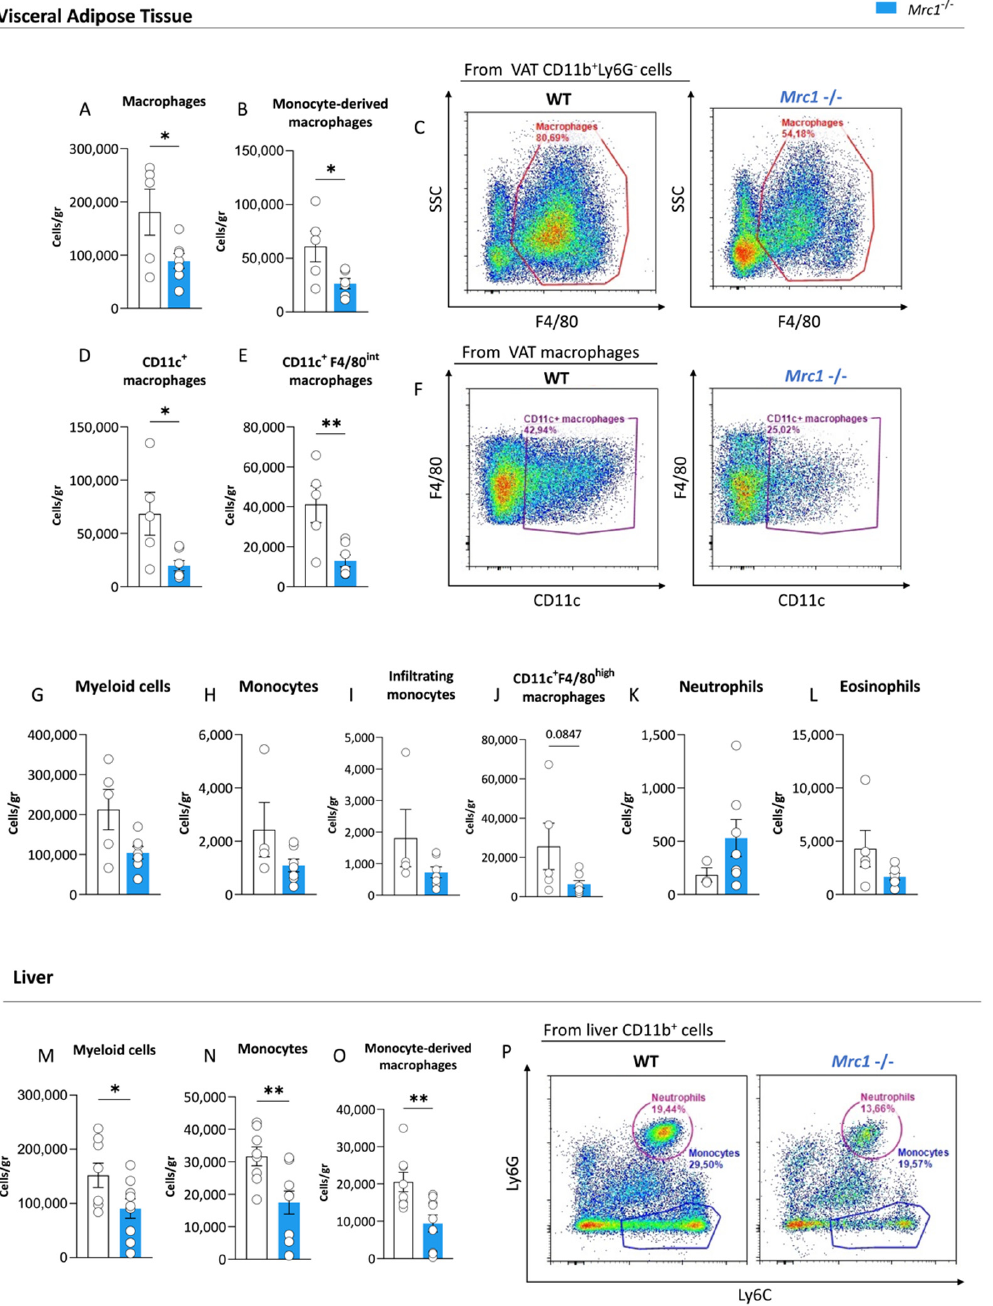
Figure 3. Immune cell subset distribution in visceral adipose tissue and liver from Mrc1 -deficient and WT mice fed with an HFD for 20 weeks. Macrophages ( A ), CCR2 + monocyte-derived macrophages ( B ), and a representative flow cytometry plot of macrophages in WT and Mrc1 − / − mice ( C ) are shown. Inflammatory CD11c + macrophage count ( D ) and CD11c + F4/80 int macrophage count ( E ) in the two experimental groups are shown. A representative flow cytometry plot showing CD11c + macrophages in WT and Mrc1-deficient mice is shown in panel ( F ). VAT counts of myeloid cells ( G ), monocytes ( H ), CCR2 + infiltrating monocytes ( I ), CD11c + F4/80 high macrophages ( J ), neutrophils ( K ), and eosinophils ( L ) are shown. Liver myeloid cells ( M ), monocytes ( N ) and CCR2 + monocyte-derived macrophages ( O ), and representative plots showing neutrophils and monocyte distribution in the two experimental groups are presented in ( P ). Results are expressed as mean ± SEM, n = 5–10 mice per group. * p < 0.05; ** p <